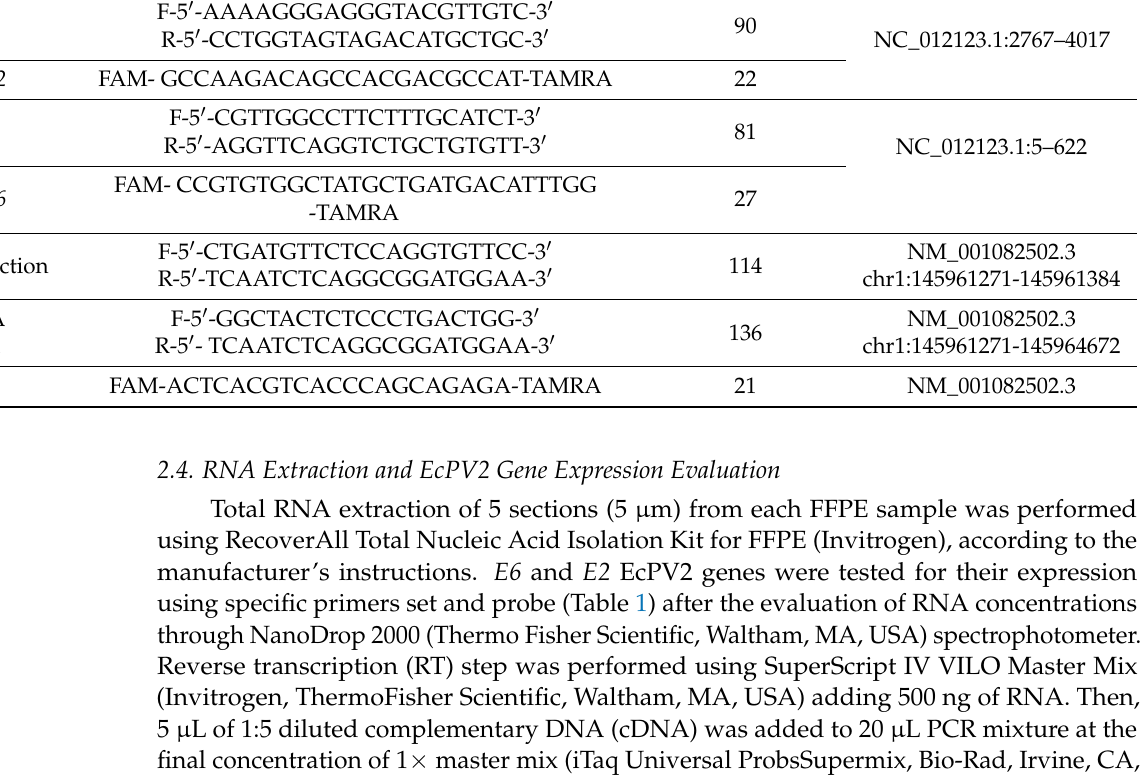
Table 1. Primer set and probes used to evaluate equine papillomavirus 2 (EcPV2) DNA detection and gene expression. Gene